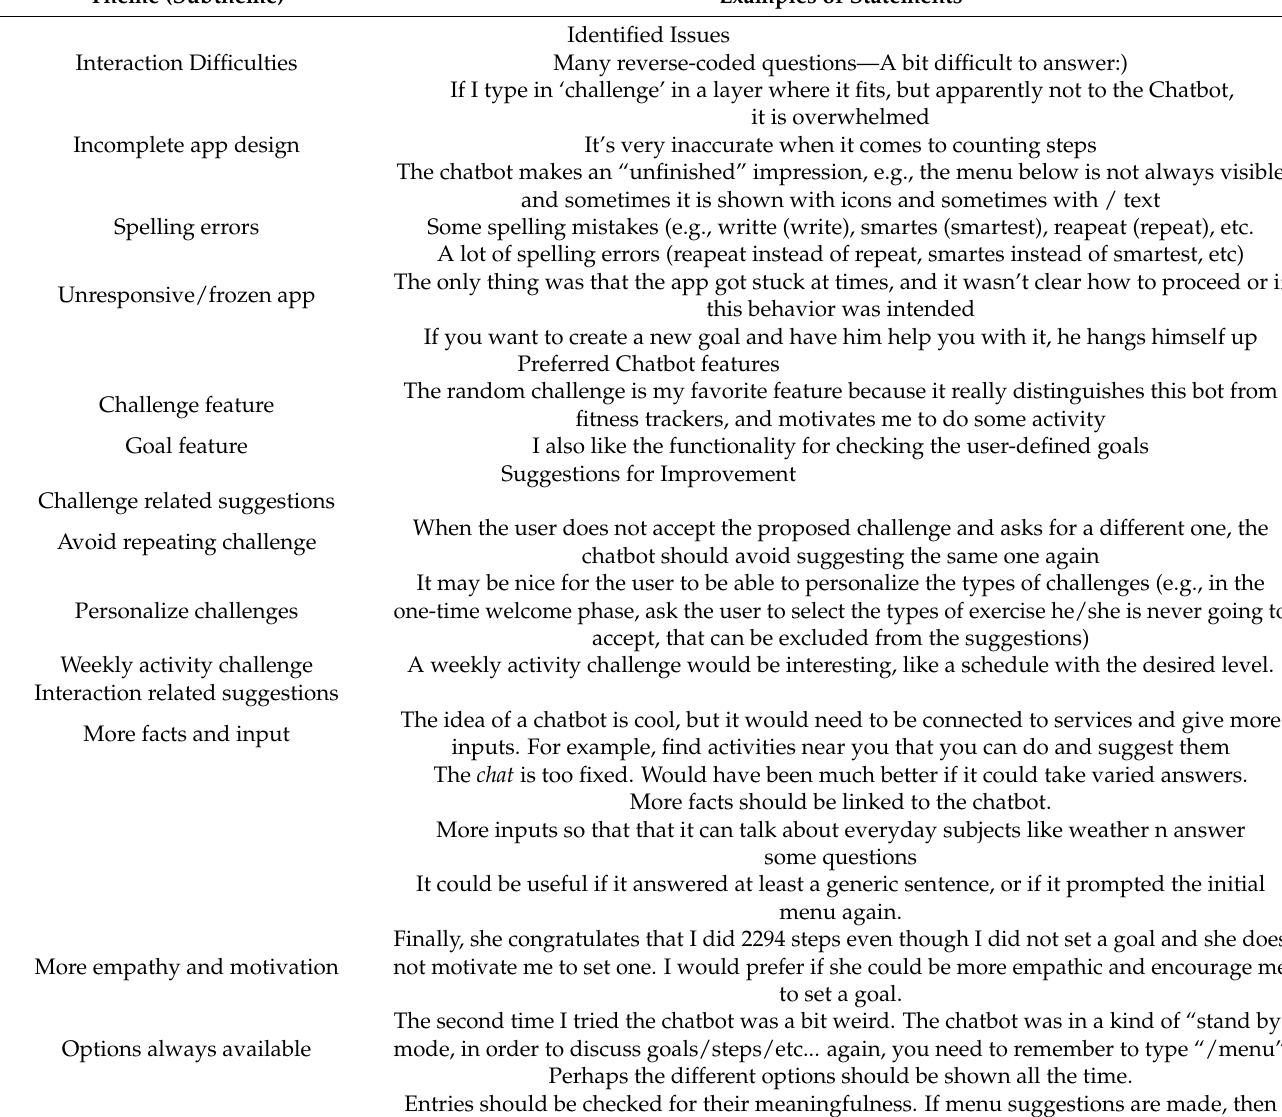
Table A2. Identified themes from the comments of respondents of the chatbot usability testing